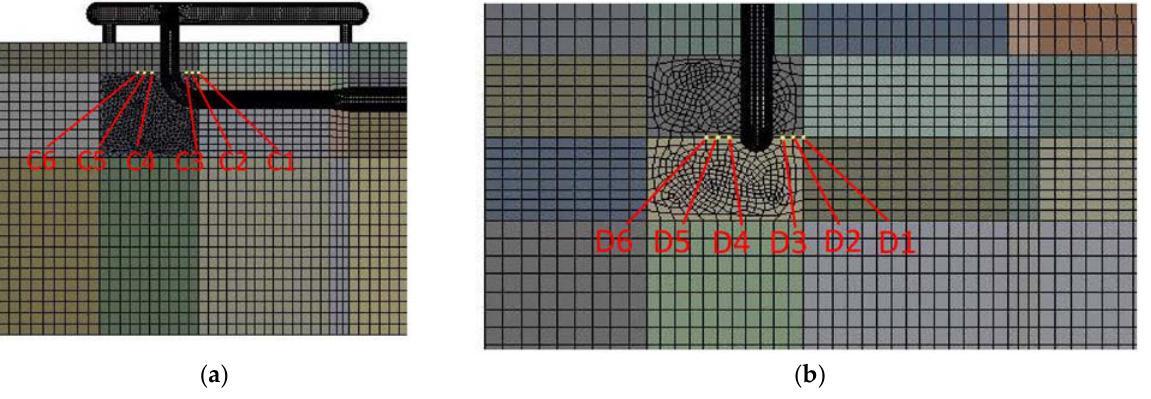
Figure 12. Plot of soil temperature around the ascending pipe into the ground: ( a ) section A; ( b ) section B.